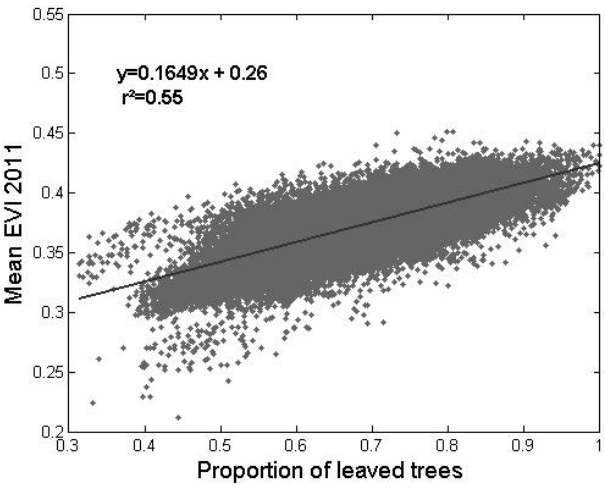
Fig. 4. Linear model II regression between the proportion of leaved trees and mean EVI values averaged for the dry season of 2011. x axis: proportion of leaved trees calculated for two different SPOT-5 images acquired in January of 2011 (dry season). y axis: mean EVI values for the dry season of the year 2011. The analysis is performed at the resolution of the MODIS product